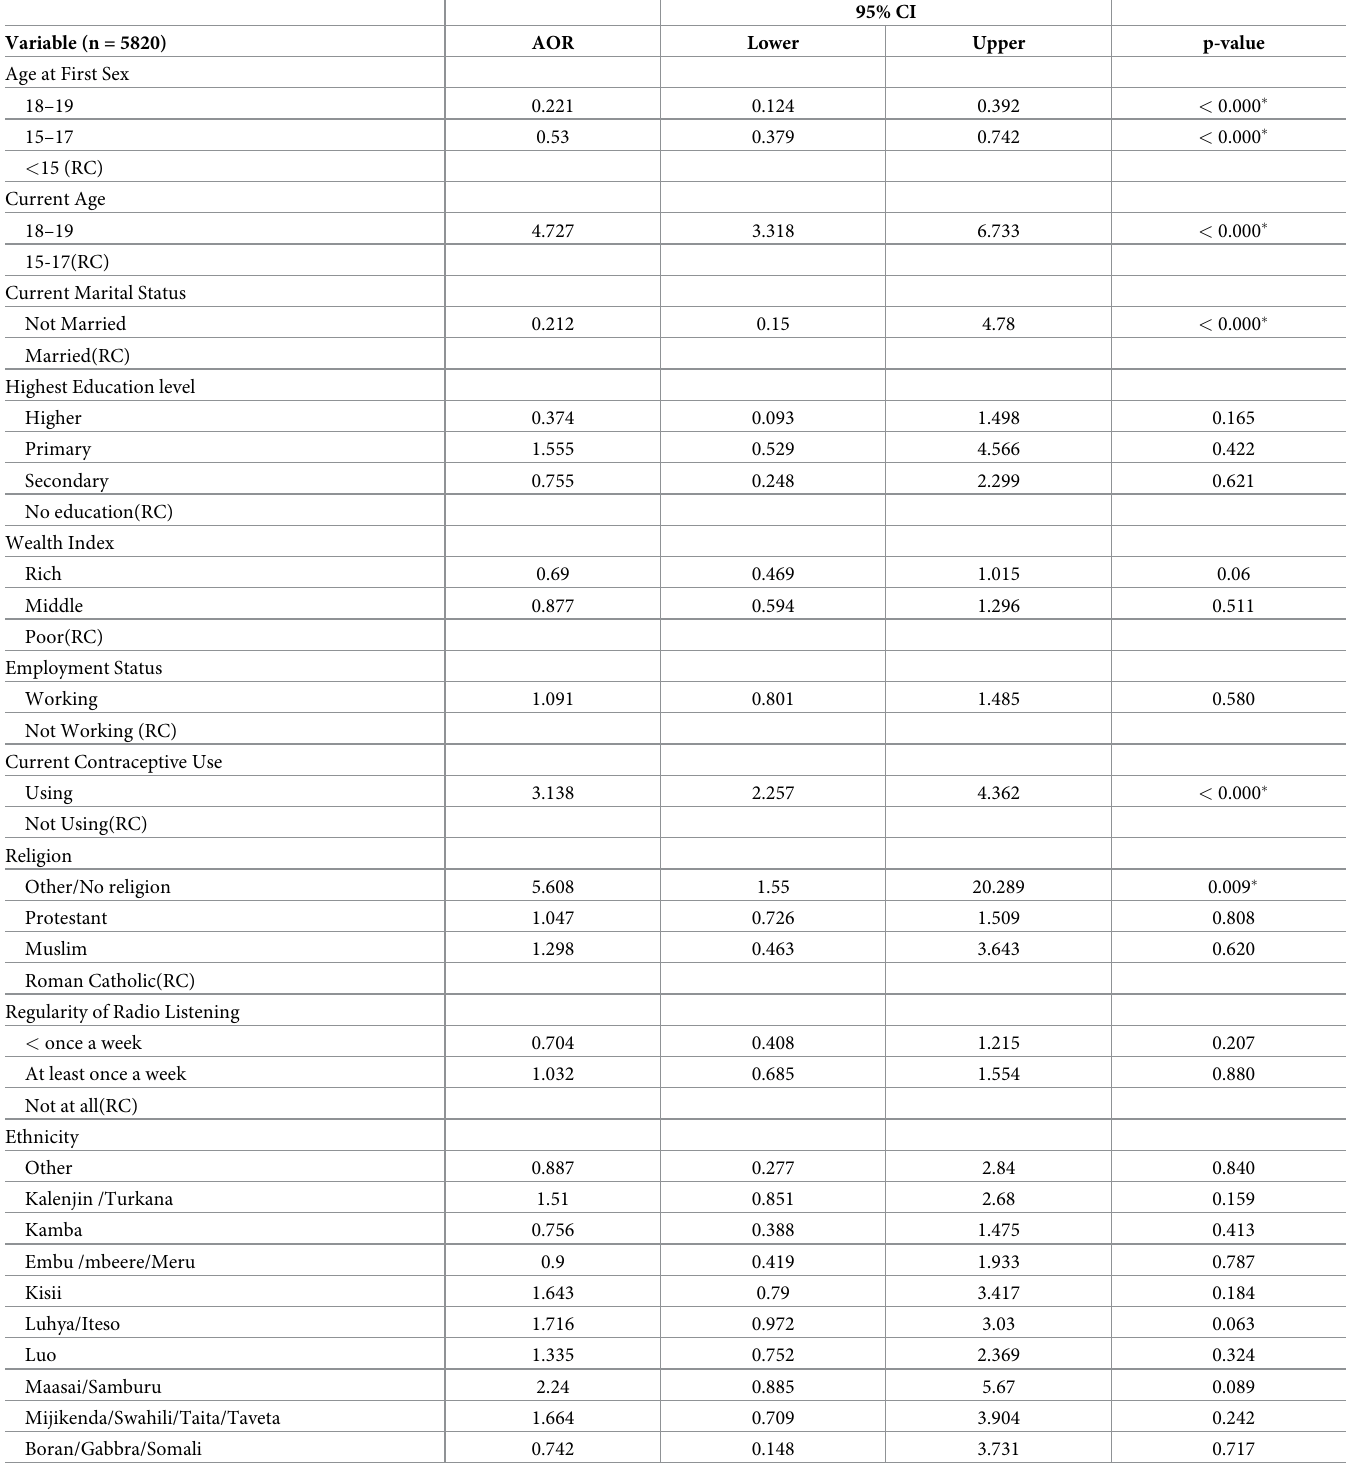
Table 4. Determinants of adolescents fertility in Kenya,